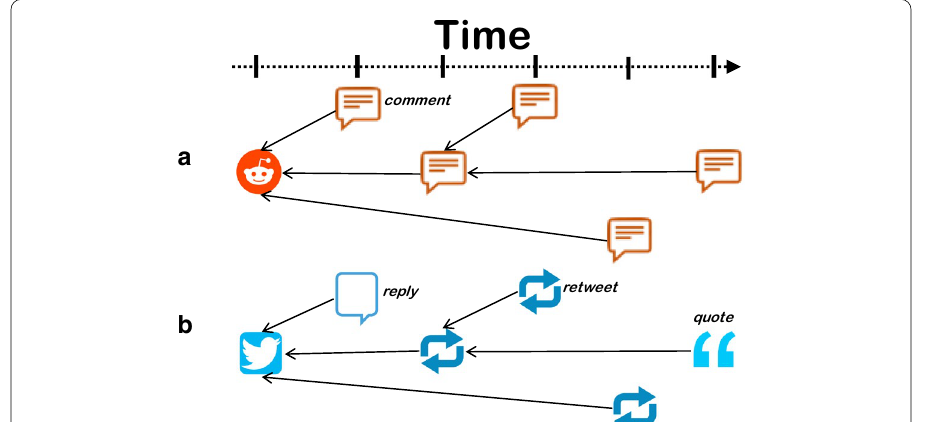
Fig. 1 Examples of conversation trees on a Reddit—a post followed by comments, and on b Twitter—a tweet followed by retweets, replies, and/or quotes. Link directions represent attention toward previous posts